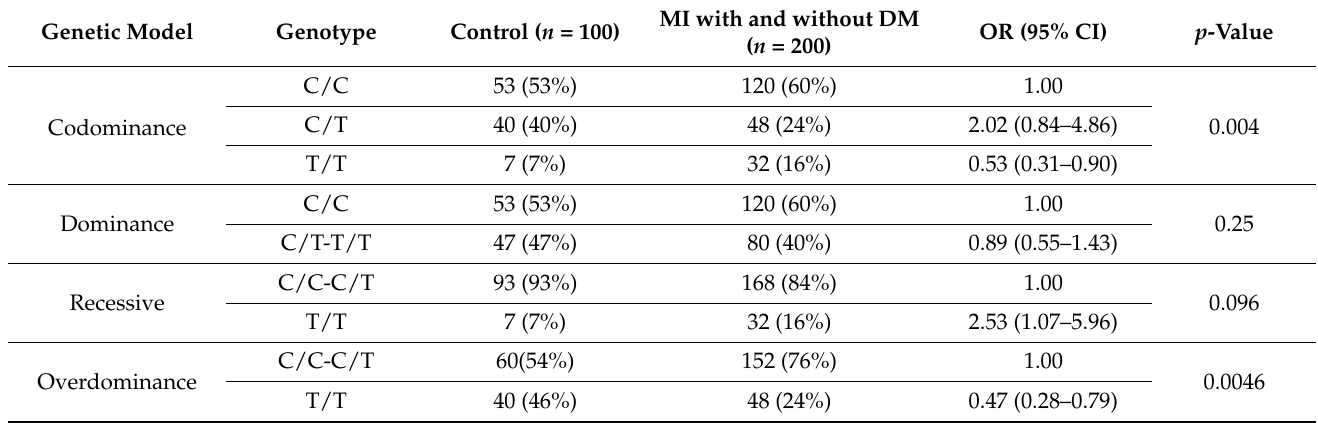
Table 8. Association of MTHFR C677T (rs1801133) single nucleotide polymorphism in control and myocardial infarction (MI) with and without diabetes mellitus (DM) study groups ( n =